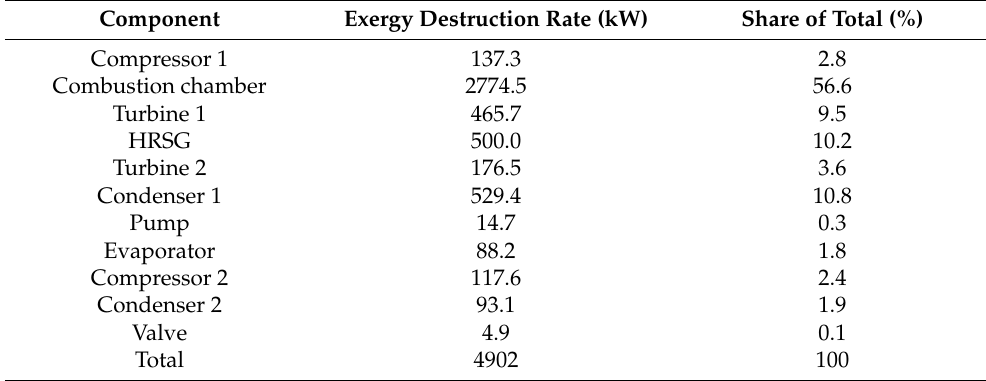
Table 4. Exergy destruction for each component in the system.